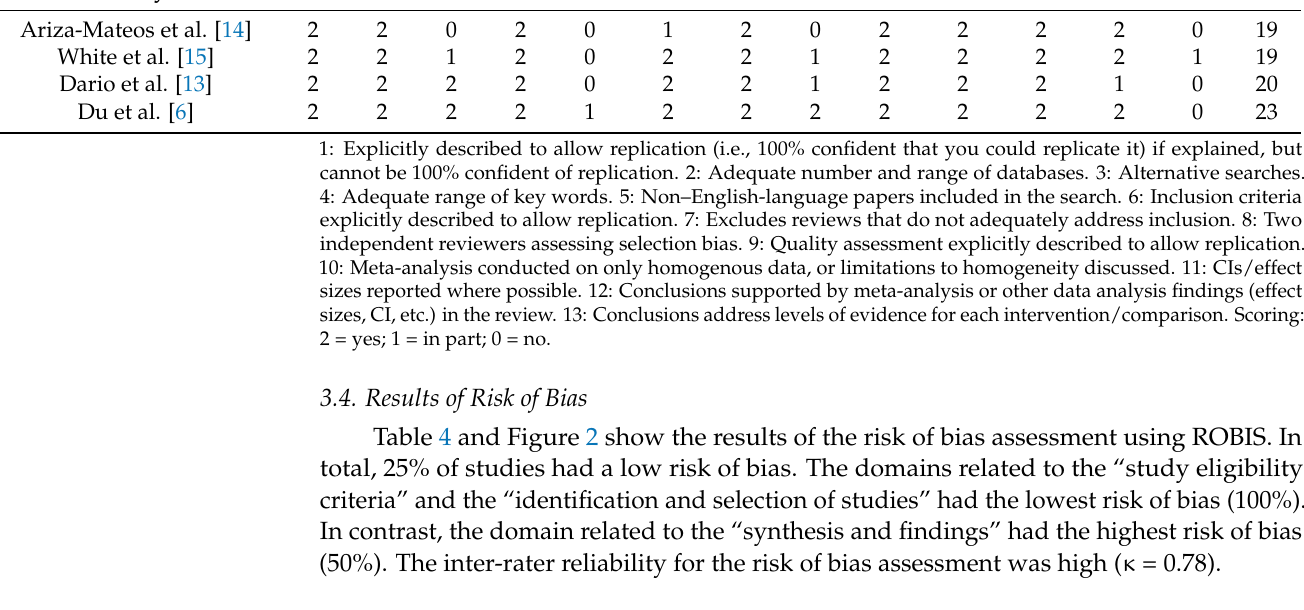
Table 4. Risk of bias assessment in systematic reviews through the ROBIS